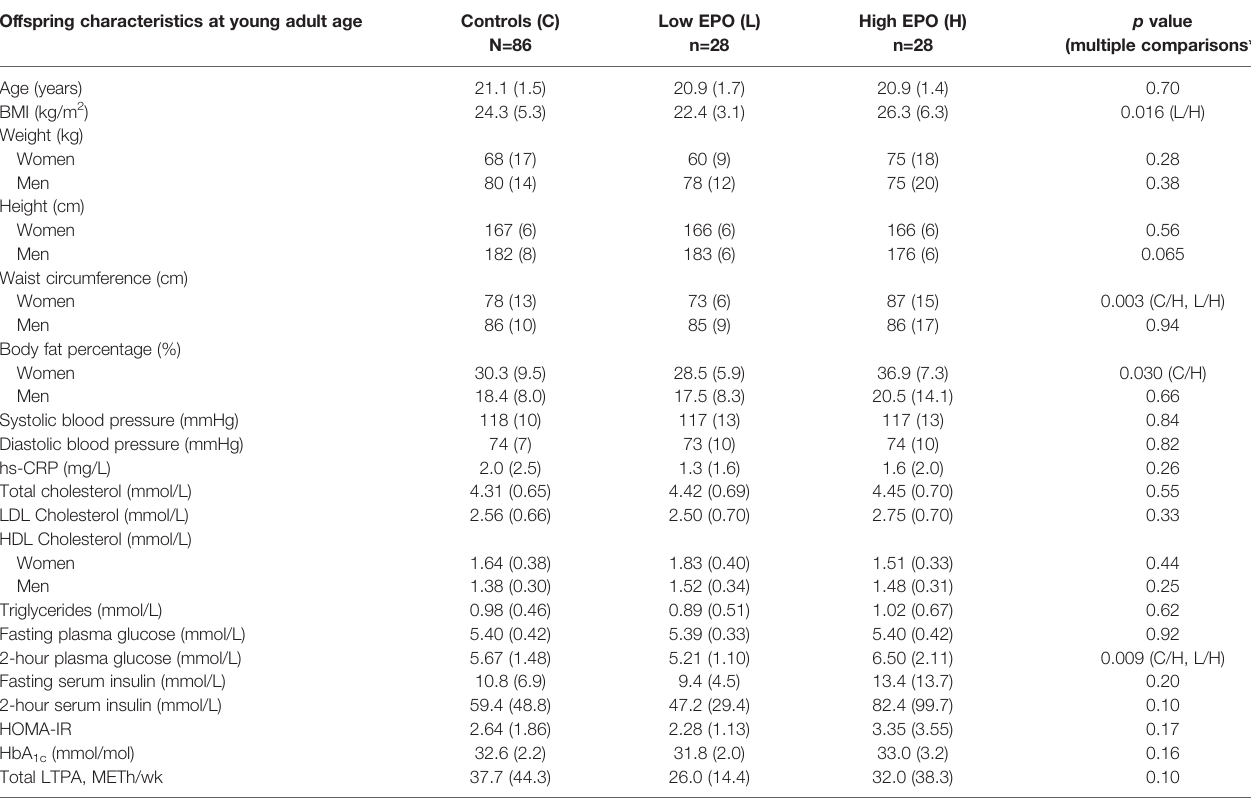
TABLE 2 | Metabolic characteristics and leisure-time physical activity (LTPA) volumes in young adult offspring born from pregnancies affected by maternal type 1 diabetes and in control (C) offspring born from non-diabetic pregnancies matched according to age and place of birth. Offspring characteristics at young adult